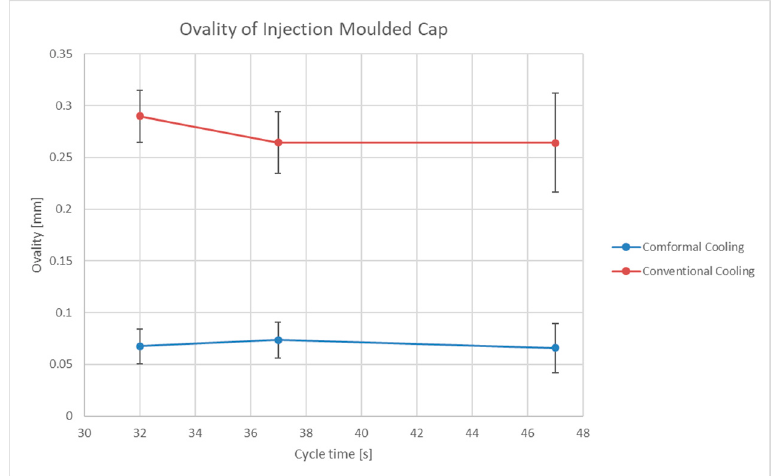
Figure 15. Unchanged ovality of inner cap threads with sinking cooling cycles when applying conformal cooling compared to overall lower dimensional accuracy and further worsening of the ovality of threads for shorter cycle time in the injection-moulding process with conventional